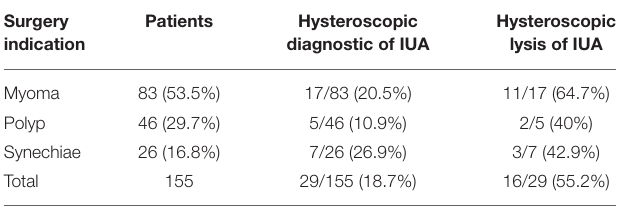
TABLE 2 | Office hysteroscopy